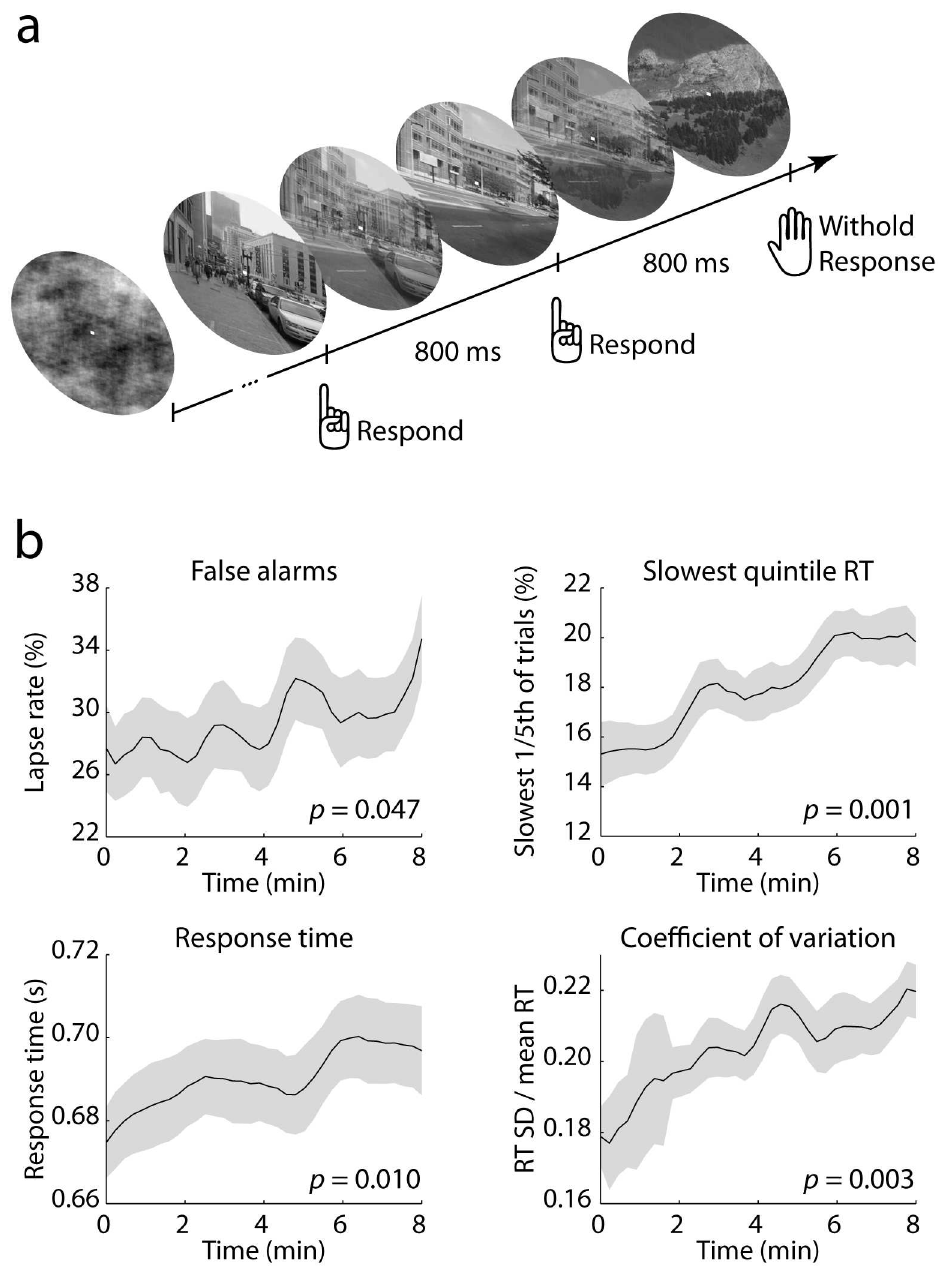
Fig 1. Task and behavioral results. a) Gradual continuousperformancetask. Each block started and ended with 7 scrambled images. The participantwas asked to respond to city scenes but not to mountain scenes. Each image continuously morphedinto the next, with an 800-ms interval between 100% coherence levels. b) Behavioral results. Data are smoothed for display only. All measures showed a significant linear increase with time-on-task, p- values are listed in the lower right corner of each panel. Error bars represent the SEM.